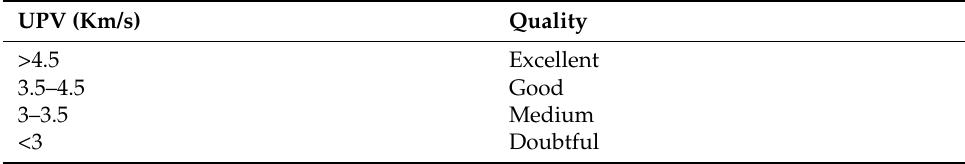
Figure 4. UPV instrument. Table 6. Velocity criteria for concrete quality grading